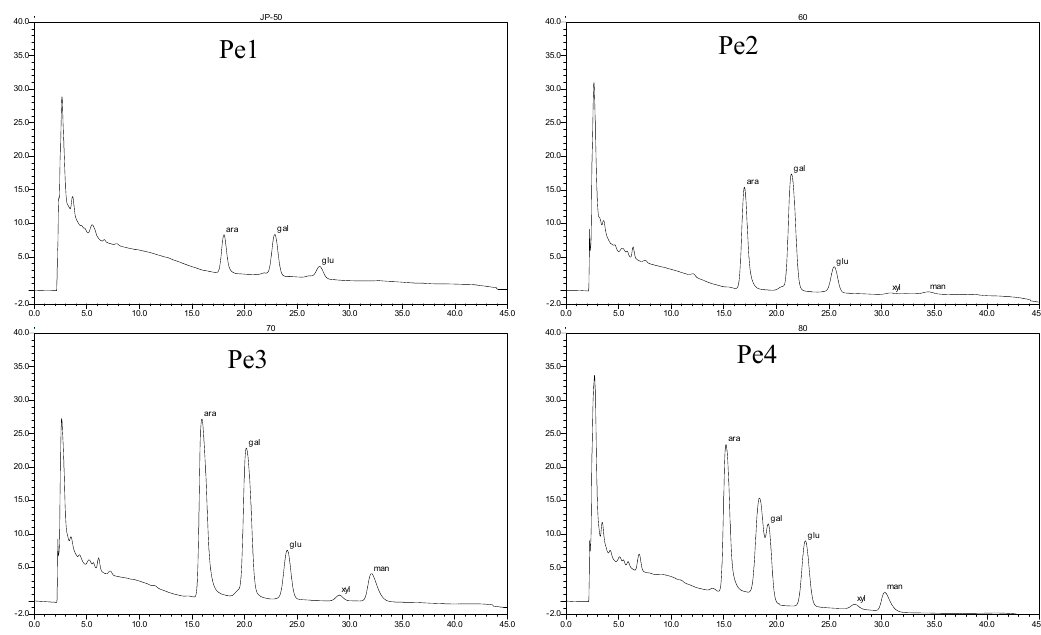
Figure 8. Monosaccharide composition of Taxus polysaccharides. Pe1: 50% alcohol-precipitated polysaccharide, Pe2: 60% alcohol-precipitated polysaccharide, Pe3: 70% alcohol-precipitated polysaccharide, and Pe4: 80% alcohol-precipitated polysaccharide. The monosaccharide composition of polysaccharides from TCBL was obtained by comparing Figure 7 with standard monosaccharide, and the results are shown in Table 4. Table 4. Analysis results of monosaccharide composition of polysaccharides from TCBL. 4 Purified